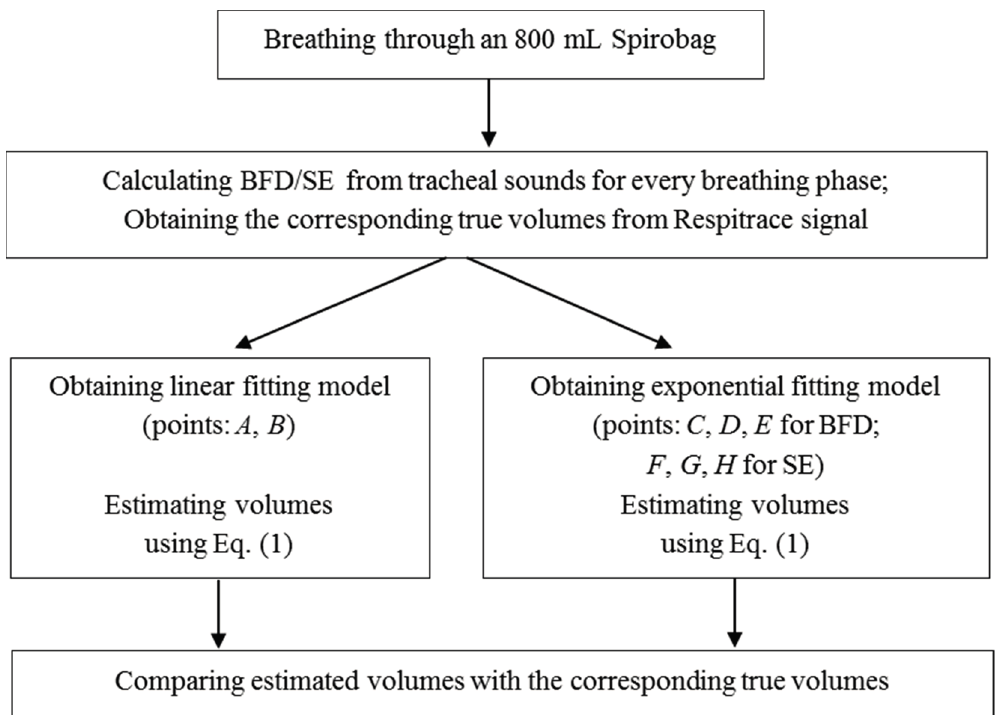
Figure 4. The flowchart showing the computation of the fitting